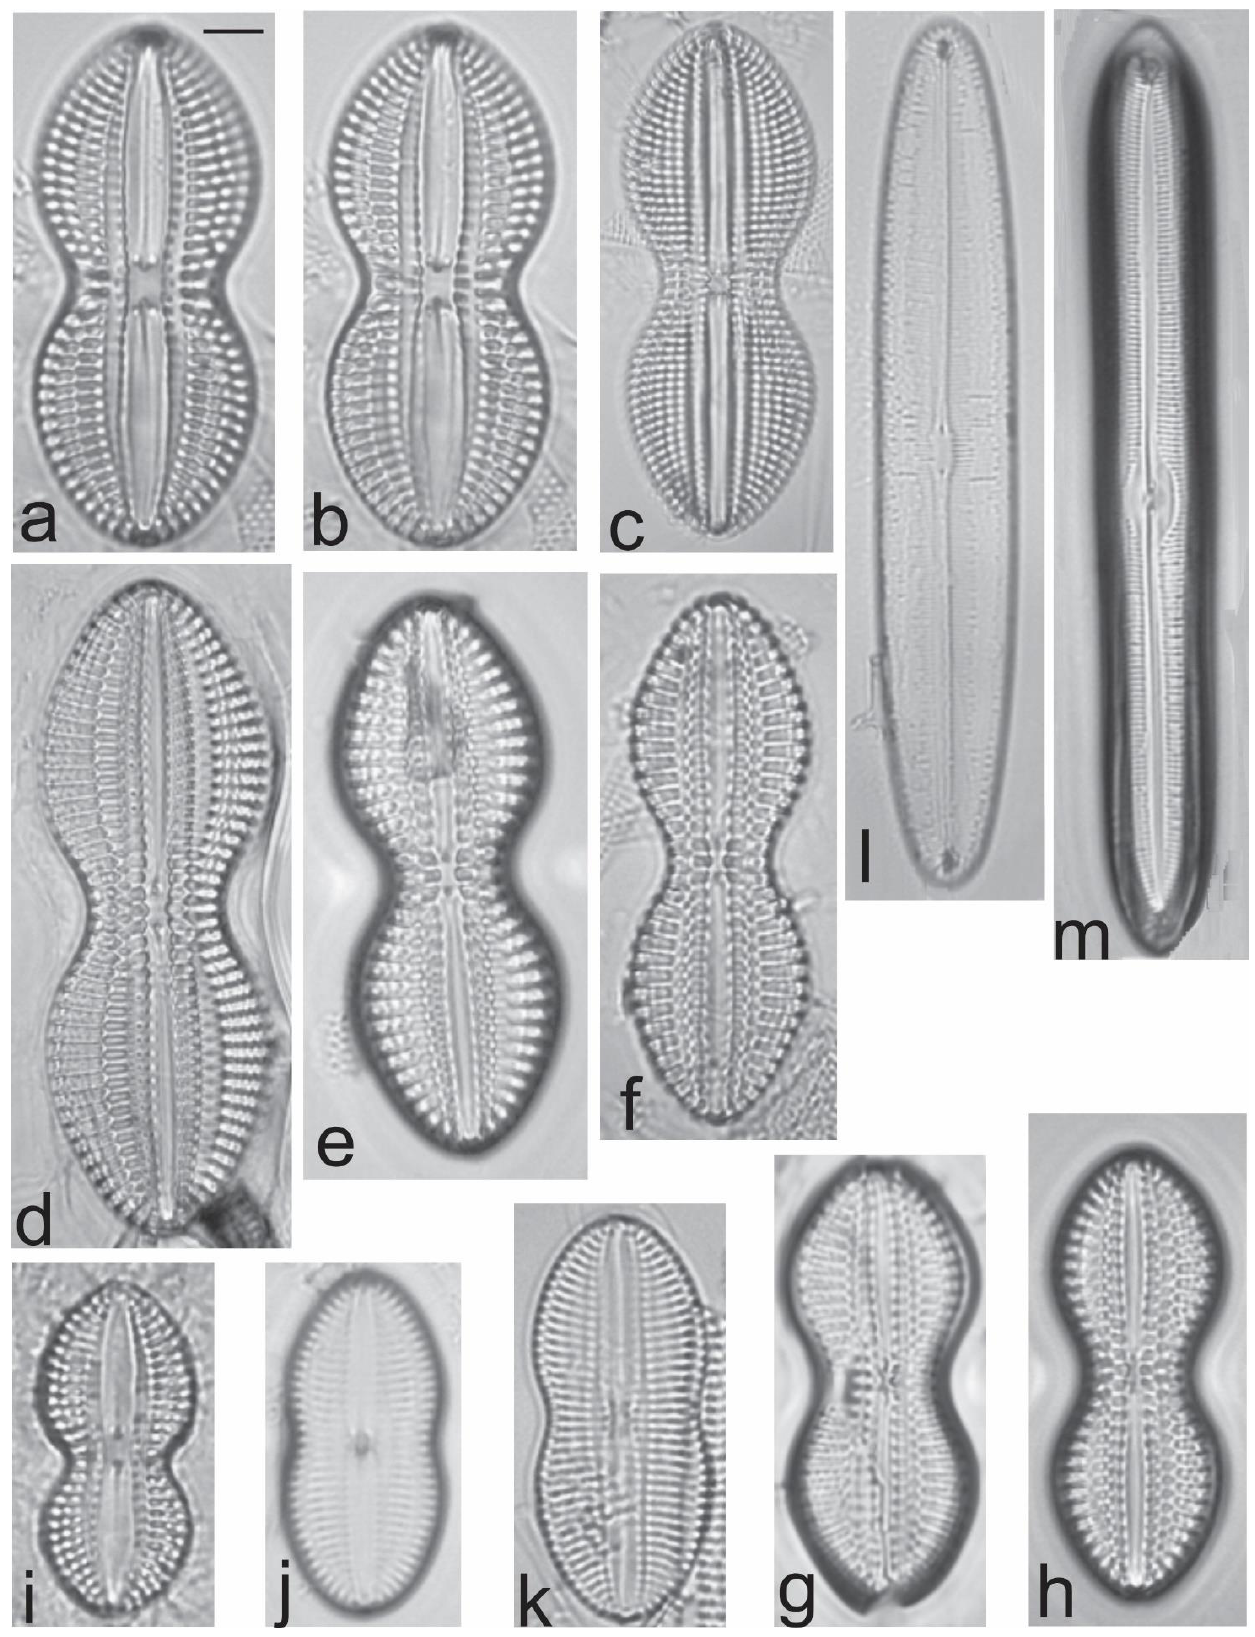
Figure 23. ( a , b ) Diploneis bombus ; ( c ) D . chersonensis ; ( d – h ) D . crabro ; ( i ) D. gruendleri ; ( j , k ) Diploneis cf. didyma ; ( l ) Caloneis maxima var . bicuneata ; ( m ) C. elongata . Scale bar = 6 μm.